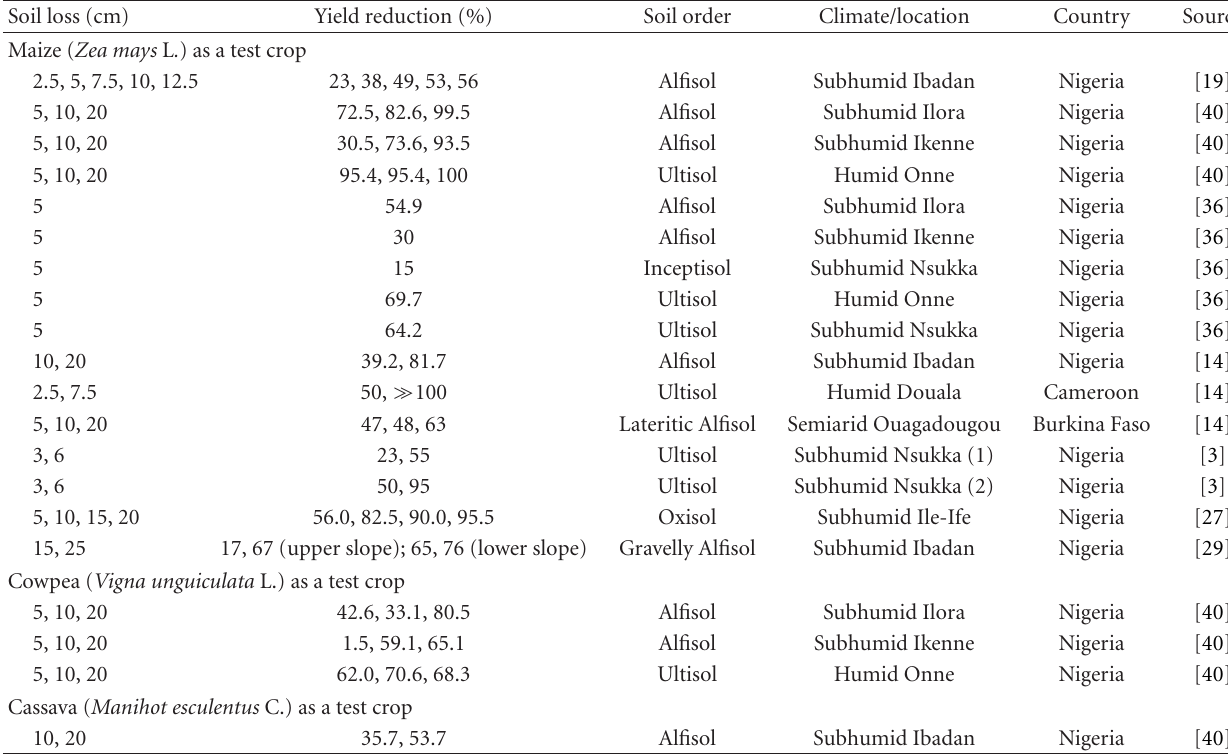
Table 1: Erosion-productivity relationship for soils of Sub-Saharan Africa (desurfacing experiments).